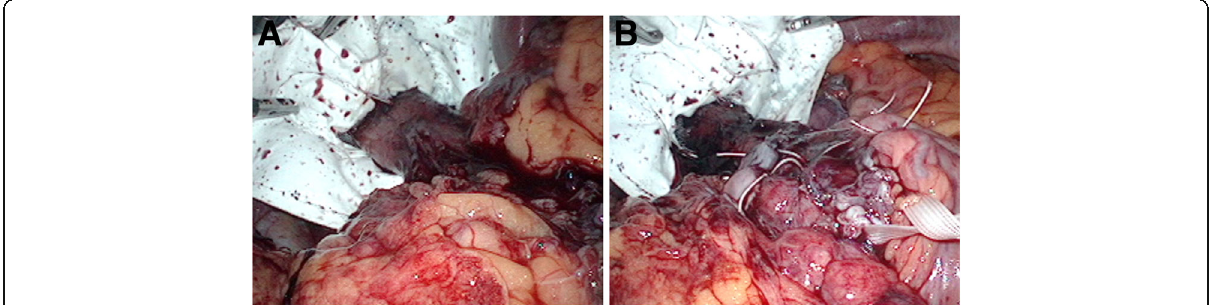
Fig. 1 a An operative field after the mesh repair. b An operative field after Toupet